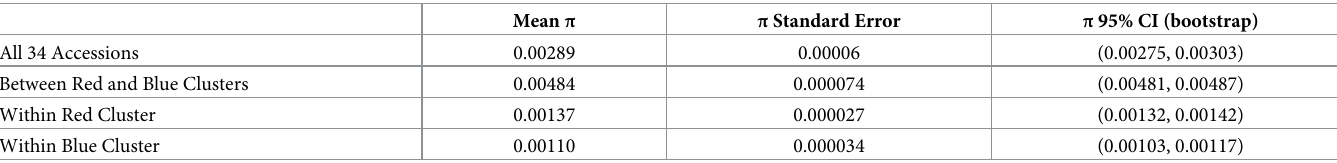
Table 5. Nucleotide diversity within and between red and blue